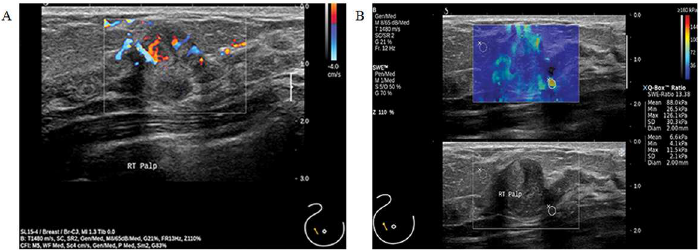
Fig 1. Atypical papilloma of the right breast in a 44-year-oldwoman. (A, B) This lesionwas initially diagnosed a benignpapillomaon ultrasound-guidedcore needlebiopsy. This lesion was upgradedafter surgicalexcision. (A) Color Dopplershowingincreasedvascularity in internal portion of mass. (B) The ROI of shear wave elsatographyimage (top) is set at the margin of the lesion. B-mode ultrasound (bottom) image showinga 1.7-cm sized, irregularshapedand palpablebreast lesion considered as category 4B. Adjacent ductal dilatationis also seen.